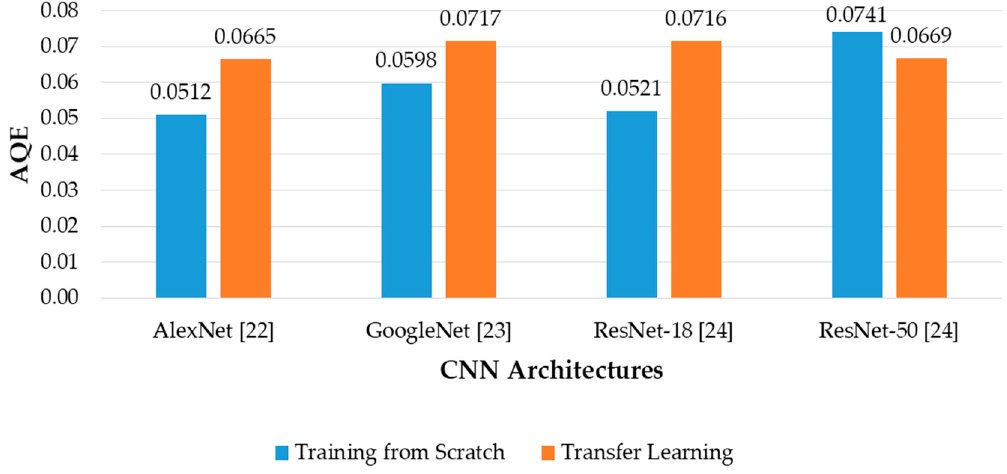
Figure 16. Average quantization error (AQE) of banknote fitness estimation using various regression CNN architectures with training from scratch and transfer learning.